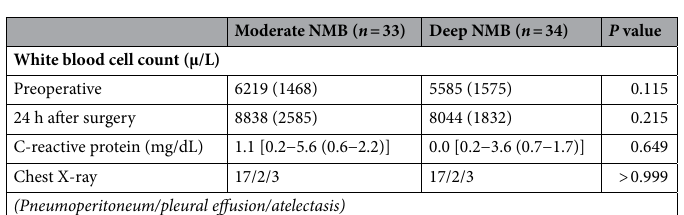
Table 3. Postoperative data. Values are presented as mean (standard deviation), median [range (interquartile range)], and the number of patients. Abbreviations: NMB, neuromuscular block.